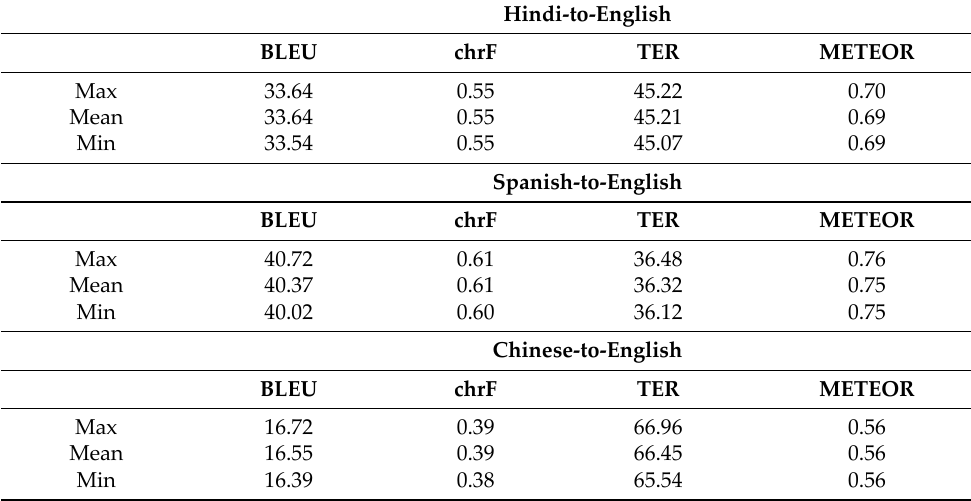
Table 9. Evaluation scores for the set of context‑insensitive